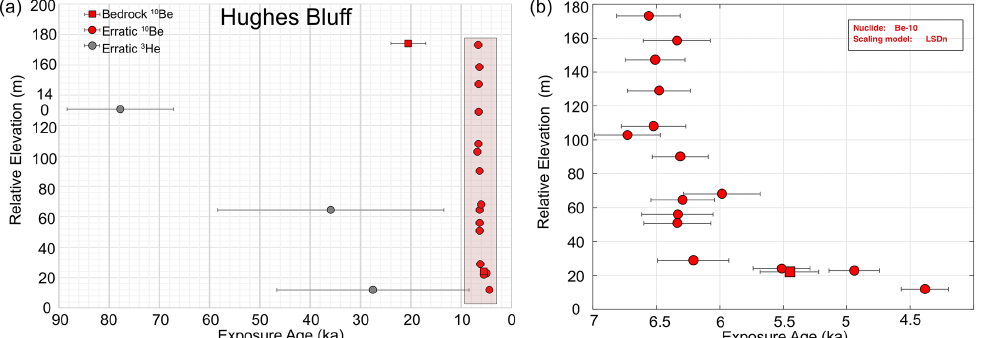
Figure 6. Relative elevation, above the ice, vs. calculated surface exposure ages for Hughes Bluff. (a) All exposure ages. Erratics plotted as circles and bedrock as squares ( 10 Be, red, and 3 He, grey). Errors bars show total uncertainty. Panel (b) shows only Holocene